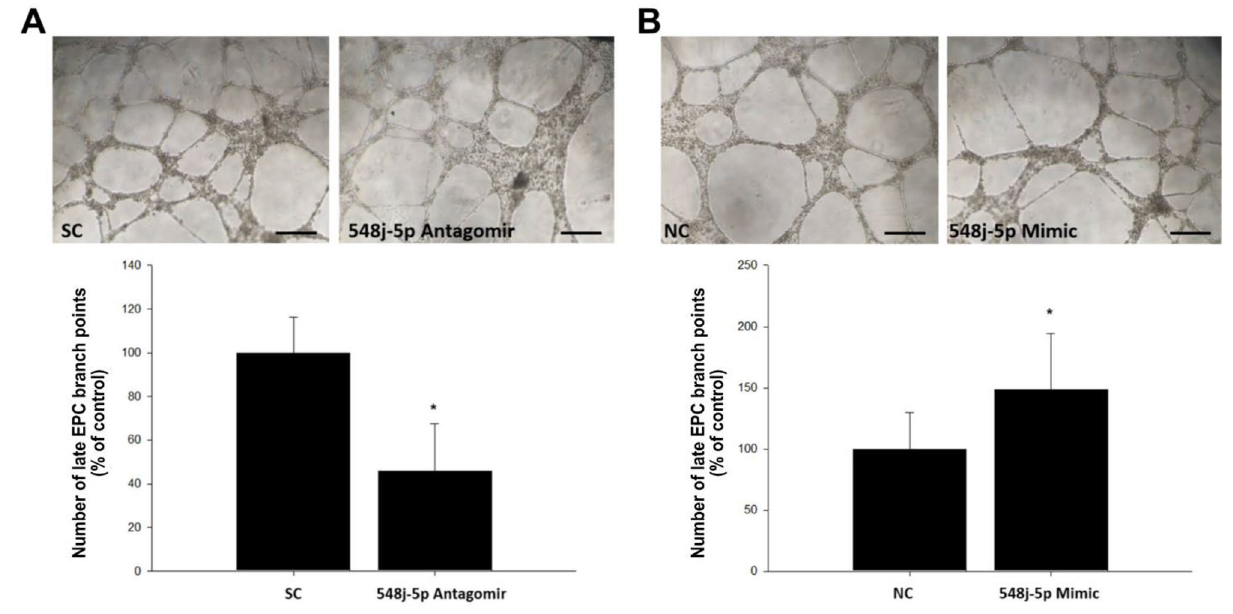
Figure 2. Effect of miR-548j-5p on human EPC tube formation. An in vitro angiogenesis assay of EPCs was performed using ECMatrix gel. ( A ) Human EPCs transfected with miR-548j-5p antagomir exhibited impaired tube formation as compared with the miR-scramble control (SC) in vitro; therefore, miR-548j-5p under- expression in EPCs could inhibit EPC tube formation. ( B ) Human EPCs transfected with miR-548j-5p mimic exhibited enhanced tube formation as compared with the miR-mimic negative control (NC) in vitro, meaning that miR-548j-5p over-expression in EPCs could promote EPC tube formation. Data are presented as the mean ± SEM (* P < 0.05 vs. control, n = 6 for each